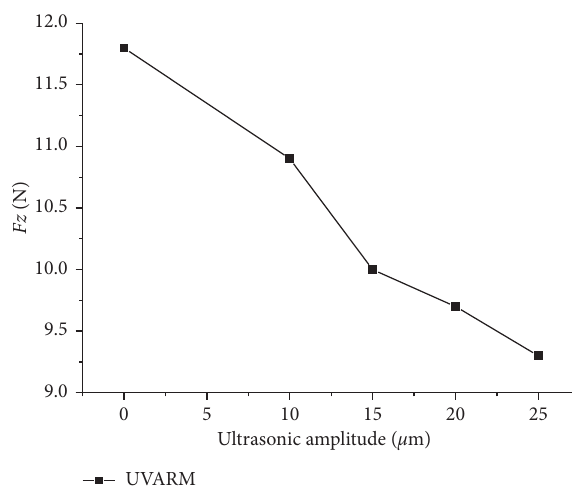
Figure 19: Fz changes with ultrasonic amplitude.